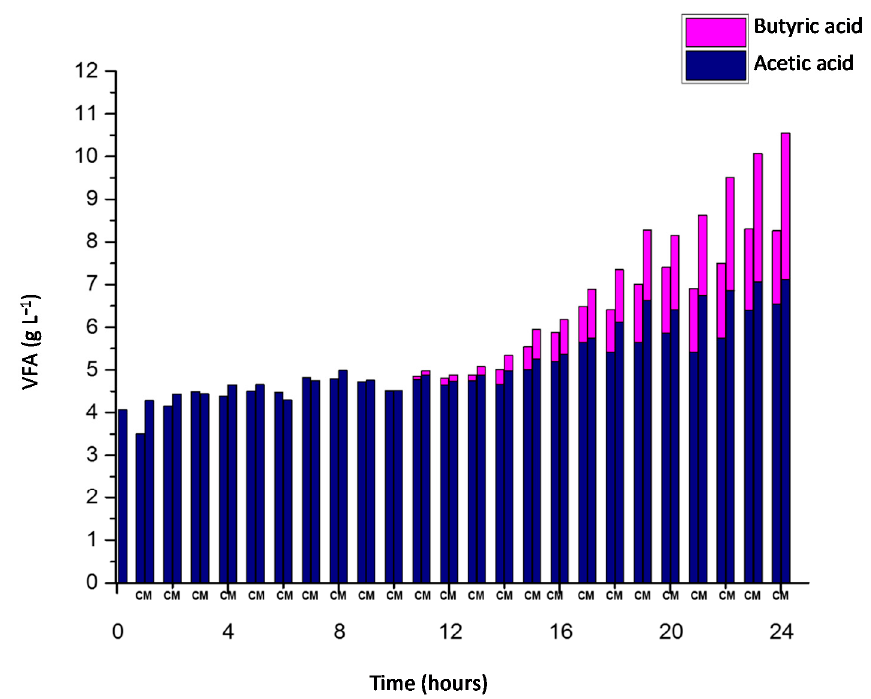
Figure 3. Volatile fatty acids concentration in APBR; with microaeration (M) and without microaeration (C) during 24 h.